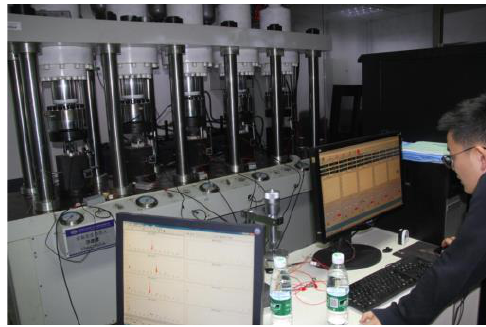
Figure 5. The five-link creep experiment system.